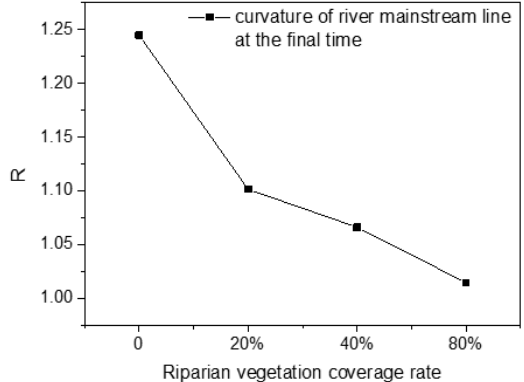
Figure 9. River bank-lines and dynamic axis for seven different experimental runs at the final relative stability moment.